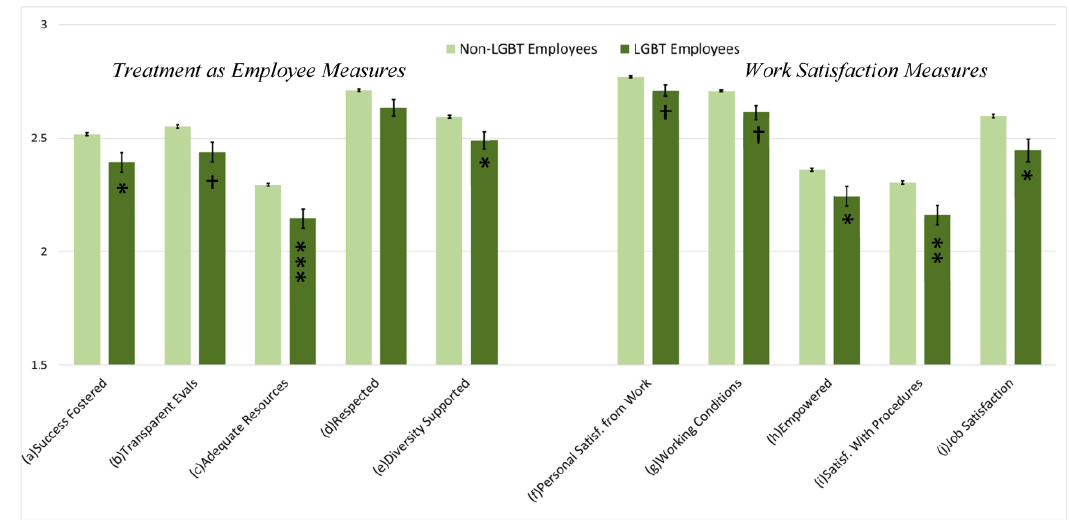
Figure 1. Workplace Experiences among Non-LGBT and LGBT Employees. Height of the columns indicates the means for LGBT and non-LGBT employees, respectively (error bars = 95% C.I.s). Asterisks indicate significance of LGBT status net of variation by gender, REM status, tenure, age category, and agency (* p < 0.05, ** p < 0.010, *** p < 0.001, based on two-tailed tests; 1 = negative, 2 = neutral, 3 = positive). See Table 3 for significance levels of the direct comparison of LGBT and non-LGBT workers.